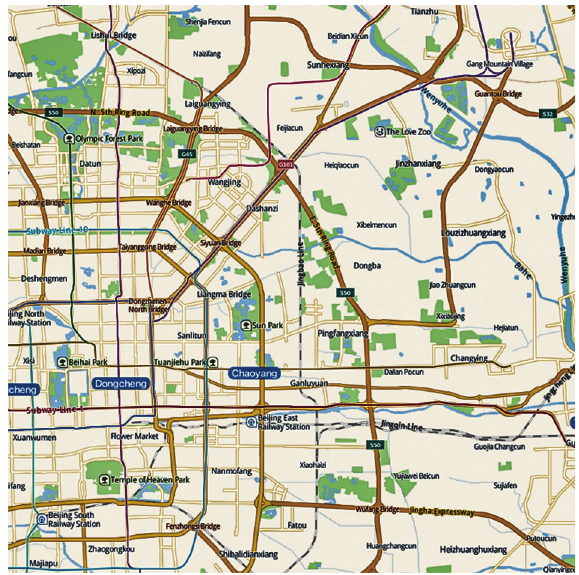
Figure 1: A distribution map of residential areas in Beijing’s Chaoyang district.